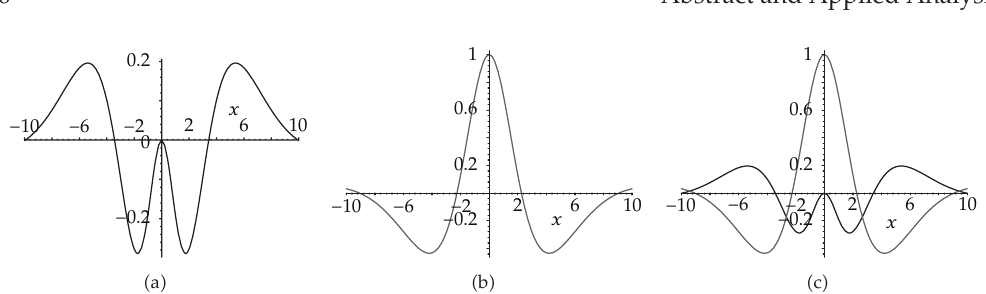
Figure 7: Parameters: c (cid:5) 1 . 0, λ (cid:5) 1 . 0, τ (cid:5) q (cid:5) 3 / 2, and γ (cid:5) 1 /q (cid:5) 2 / 3. (cid:2) a (cid:3) Forcing profile F q converges toward x (cid:5) 0 as t → 0 − ; (cid:2) b (cid:3) rogue solution Ψ q in a neighborhood of x (cid:5) 0 that oscillates over time; (cid:2) c